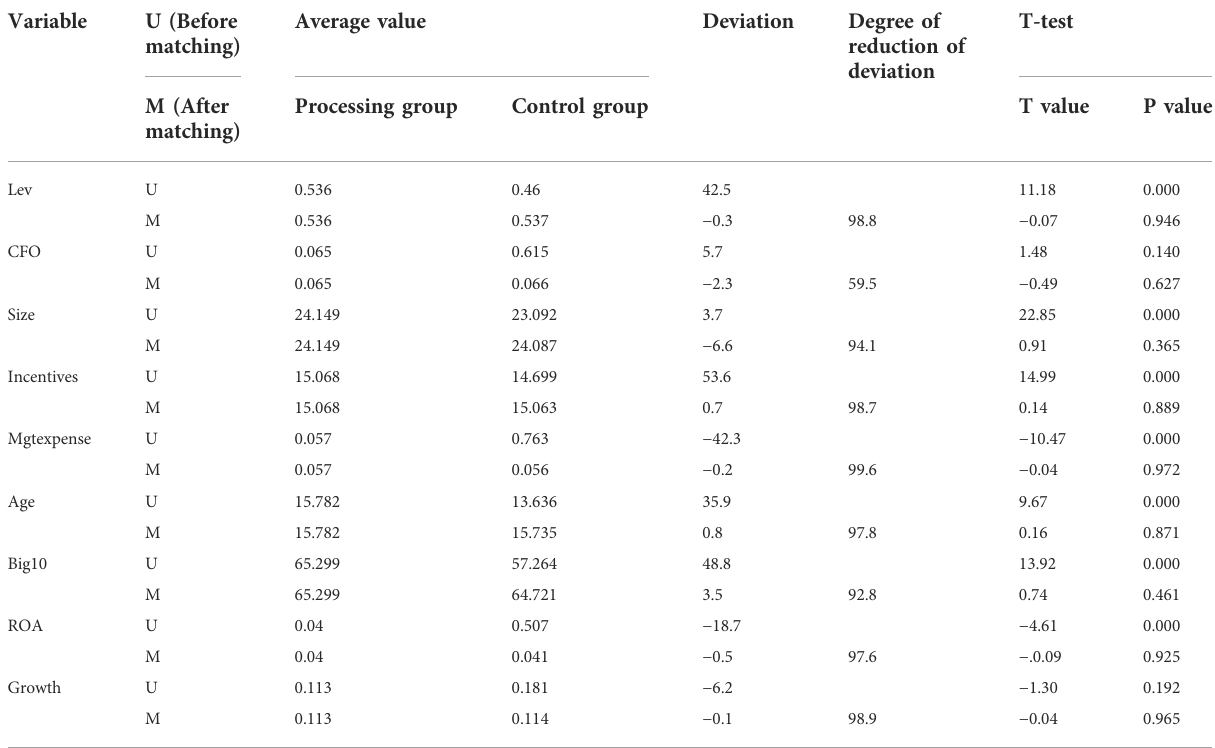
TABLE A2 Comparison of differences before and after matching variables.